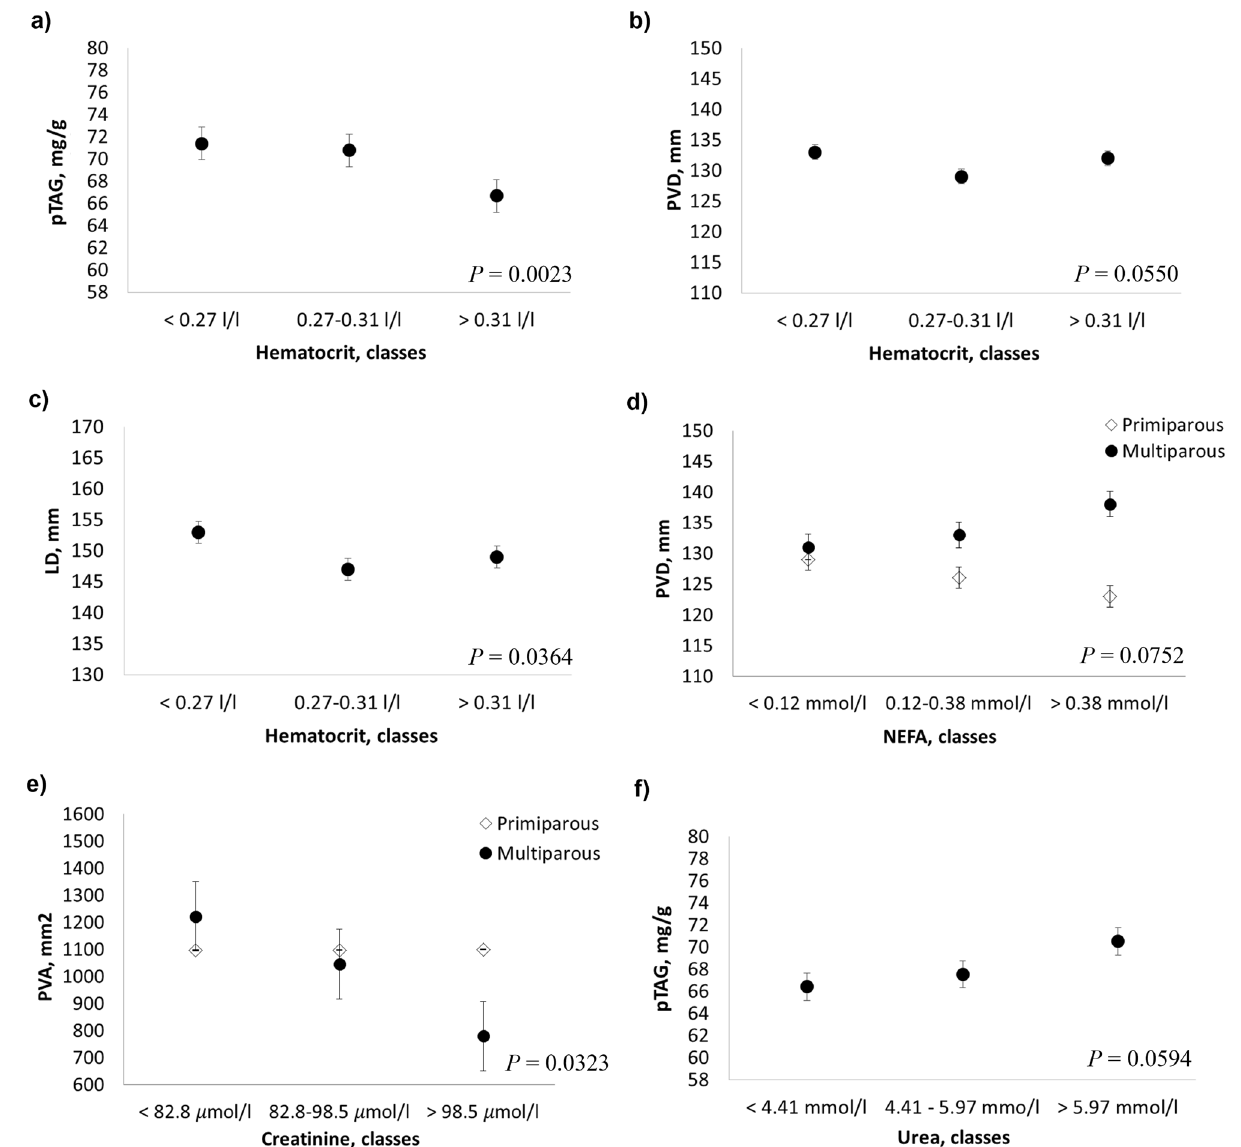
hematic minerals. ( a – c ) hematocrit; ( d ) non esterified fatty acid (NEFA); ( e ) creatinine; ( f ) urea. Black dots/ rhombus indicate the LSM and error bars indicate the standard